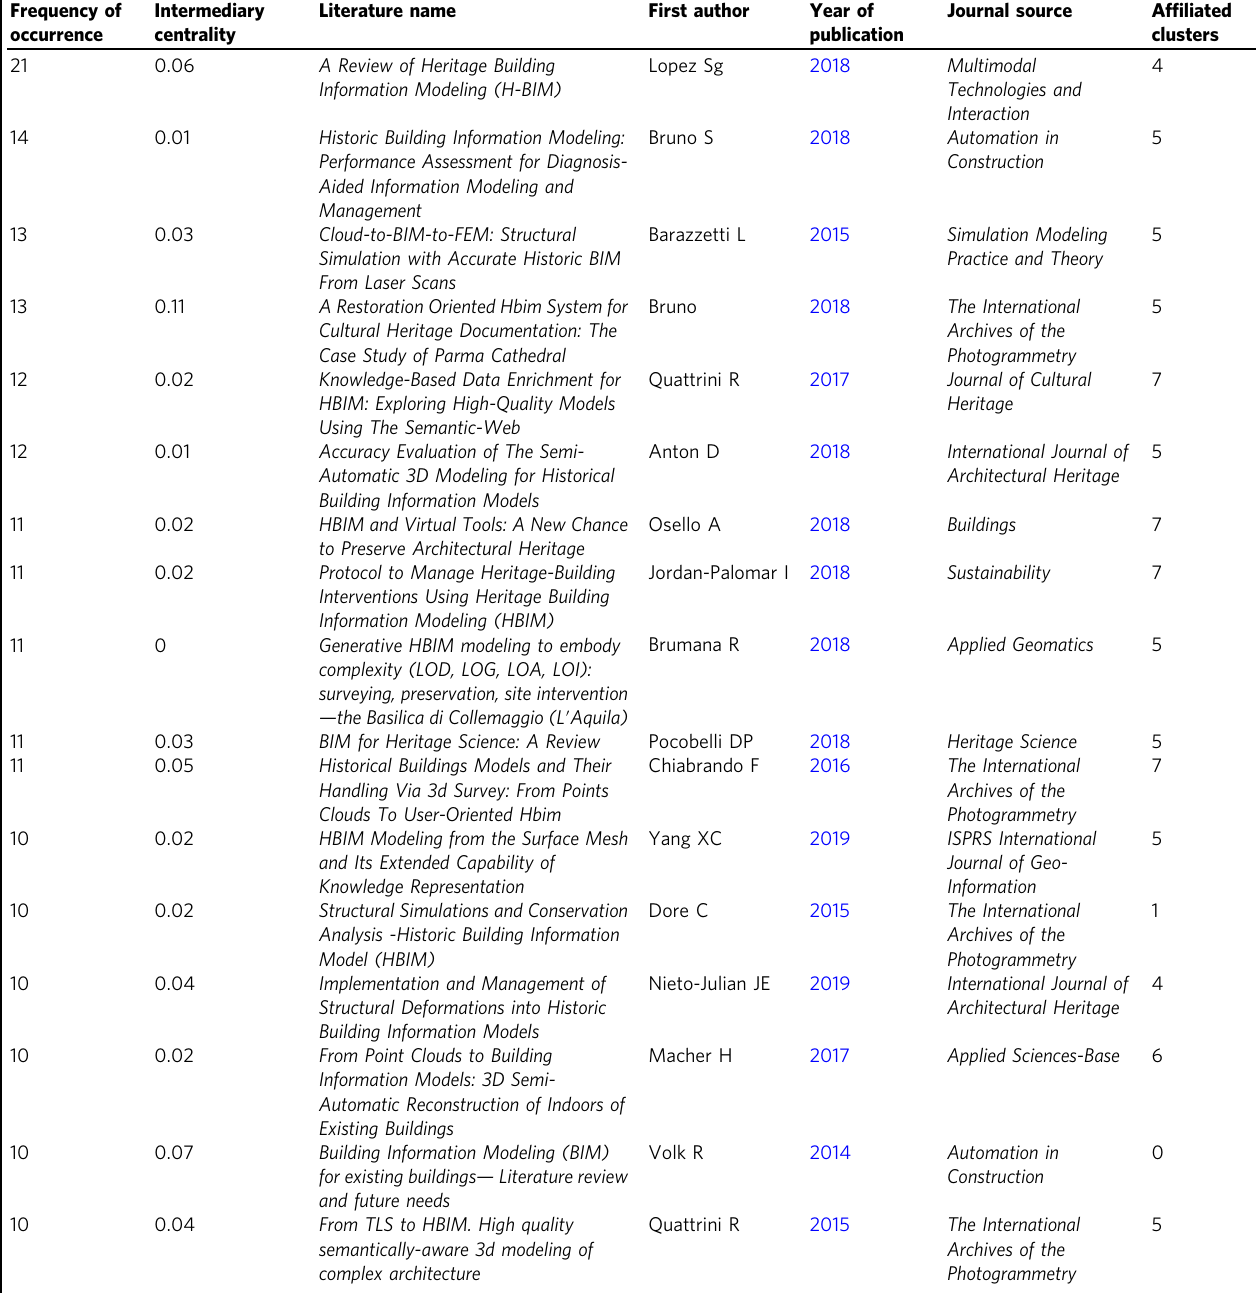
Table 7 Co-citation analysis of